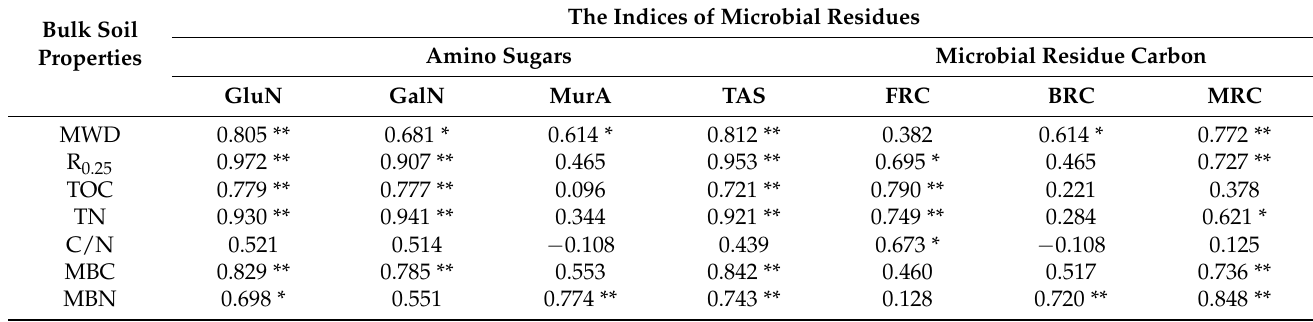
Table 2. Pearson correlations between the microbial residues and aggregate stability.